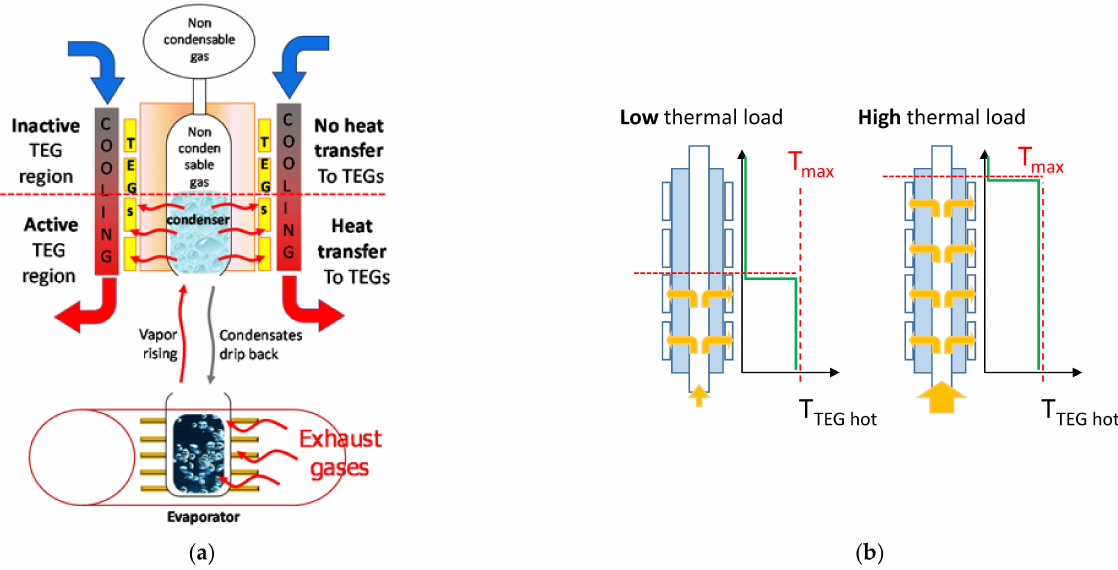
Figure 9. Outline of the temperature-controlled thermoelectric generator using a thermosiphon to supply the exhaust heat to the TE modules at a constant temperature: ( a ) full concept and ( b ) detail of the TS condenser with modules attached along its length for a low and a high thermal